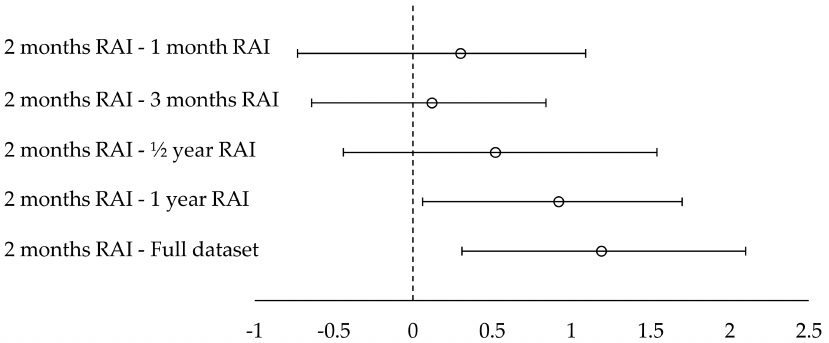
Figure 4. 95% confidence intervals for the statistical significance tests between the best performing variant (“2 month RAI”) and other variants, in the context of the second